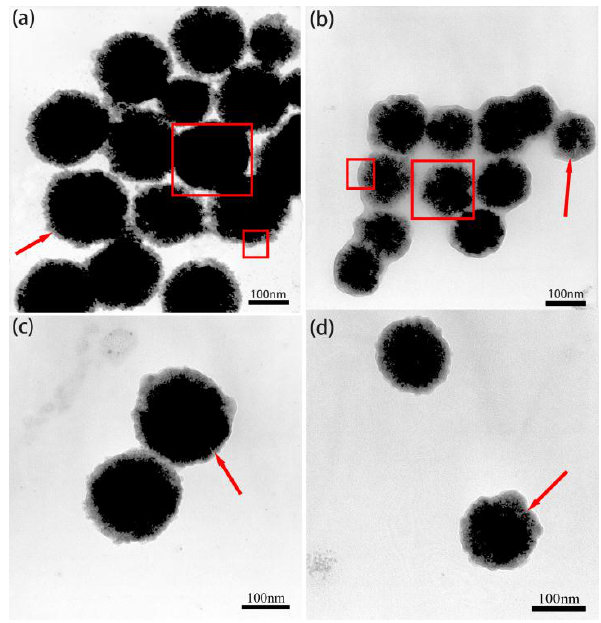
Figure 2. TEM images of ( a , c ) O -Fe 3 O 4 /FePc and ( b , d ) E -Fe 3 O 4 /FePc.